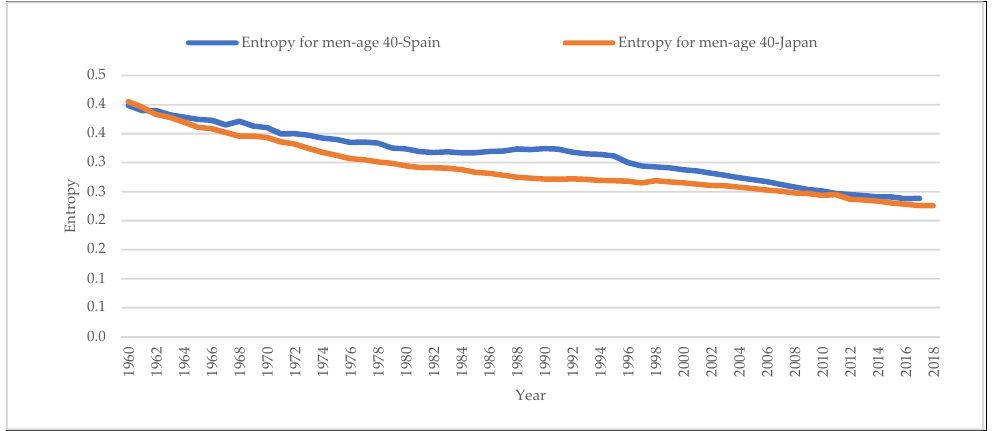
Figure 7. Entropy evolution for the male population at 40 over calendar years. Source: authors.